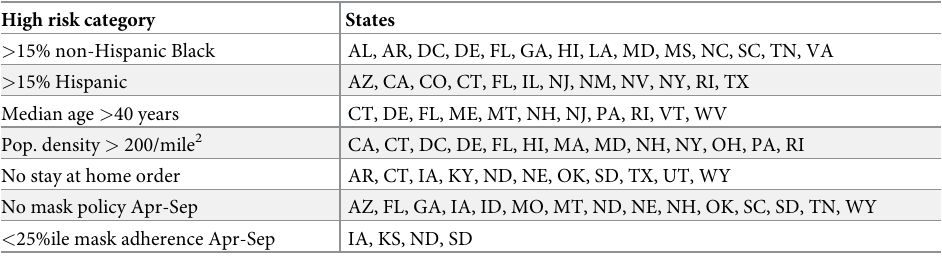
Table 1. States with high COVID-19 population risk